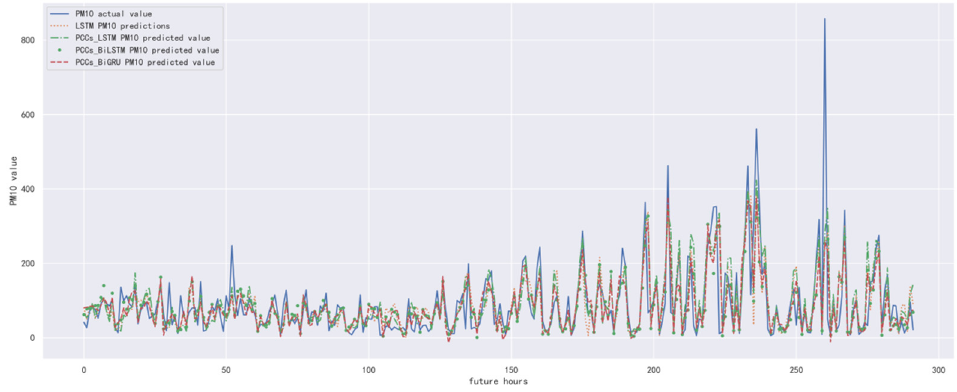
Figure 21. The schematic diagram of predicted PM 10 concentration in the next six hours. Table 8. The MAE of PM 10 concentration prediction in the next six hours.